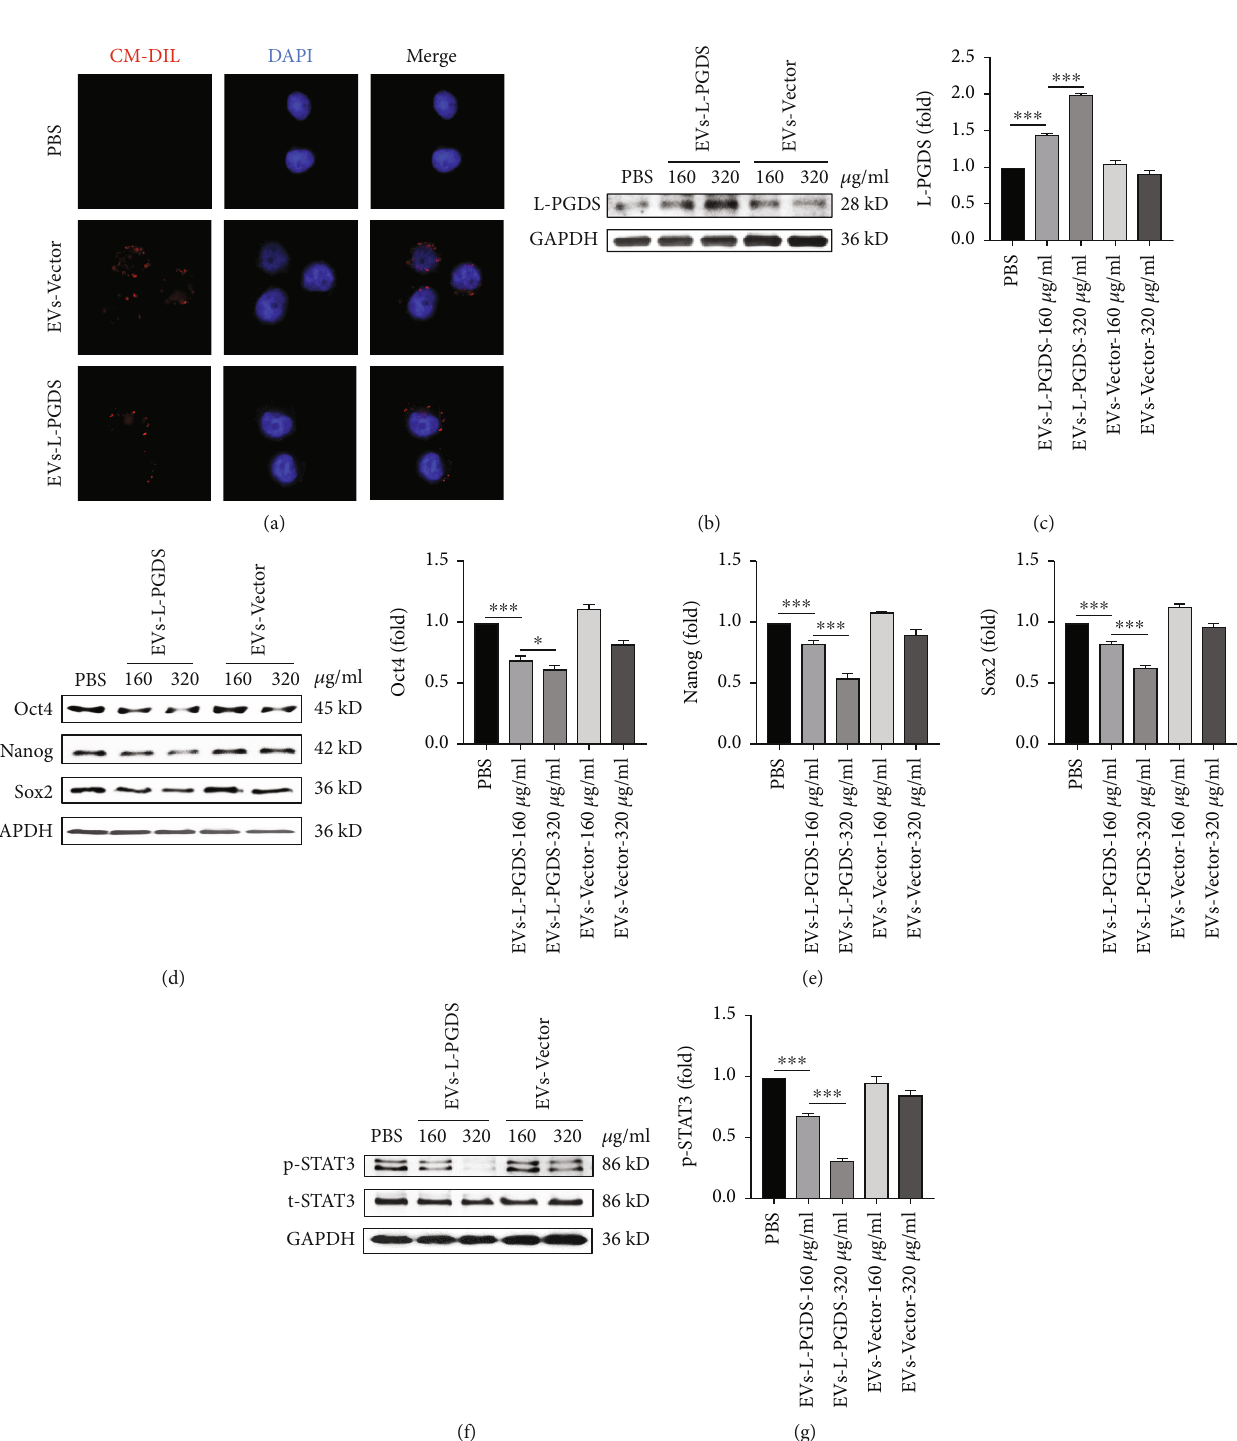
Figure 3: EVs-L-PGDS increased L-PGDS and reduced stem cell marker expression and inhibited STAT3 phosphorylation in the gastric cancer cell SGC-7901. (a) Confocal microscopy for the location of EVs in SGC-7901 cells ( × 600). (b) Western blot for the expression level of L-PGDS in SGC-7901 cells. (c) Quantitative analyses of protein expression of L-PGDS. (d) Western blot for the expression level of Oct4 , Nanog , and Sox2 in SGC-7901 cells. (e) Quantitative analyses of protein expression of Oct4 , Nanog , and Sox2 . (f) Western blot for the expression of p-STAT3 (Thy705), t-STAT3, and GAPDH in SGC-7901 cells. (g) Quantitative analyses of protein expression of p- STAT3 (Thy705). n = 3 ; ∗ P < 0 : 05 , ∗∗ P < 0 : 01 , and ∗∗∗ P < 0 : 001